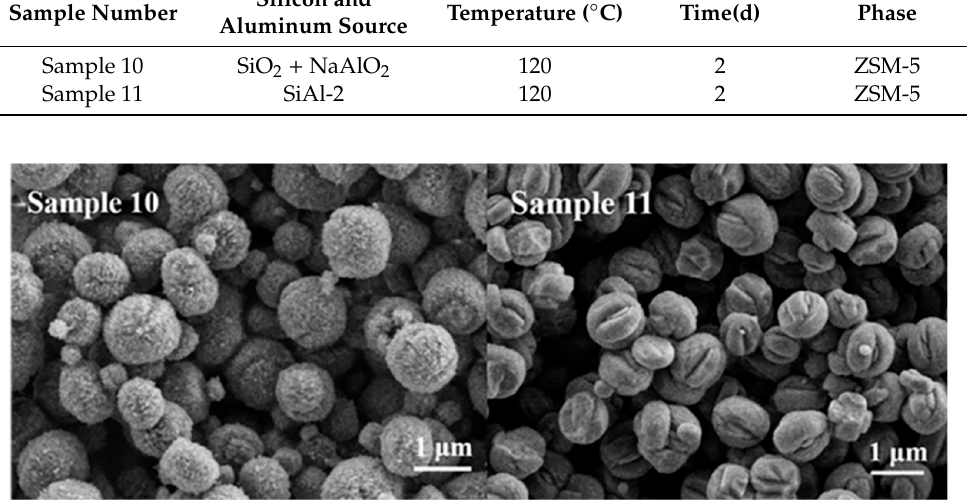
Figure 6. XRD patterns of Sample 1–9. Table 3. The reaction conditions and phases of Samples 10 and 11.